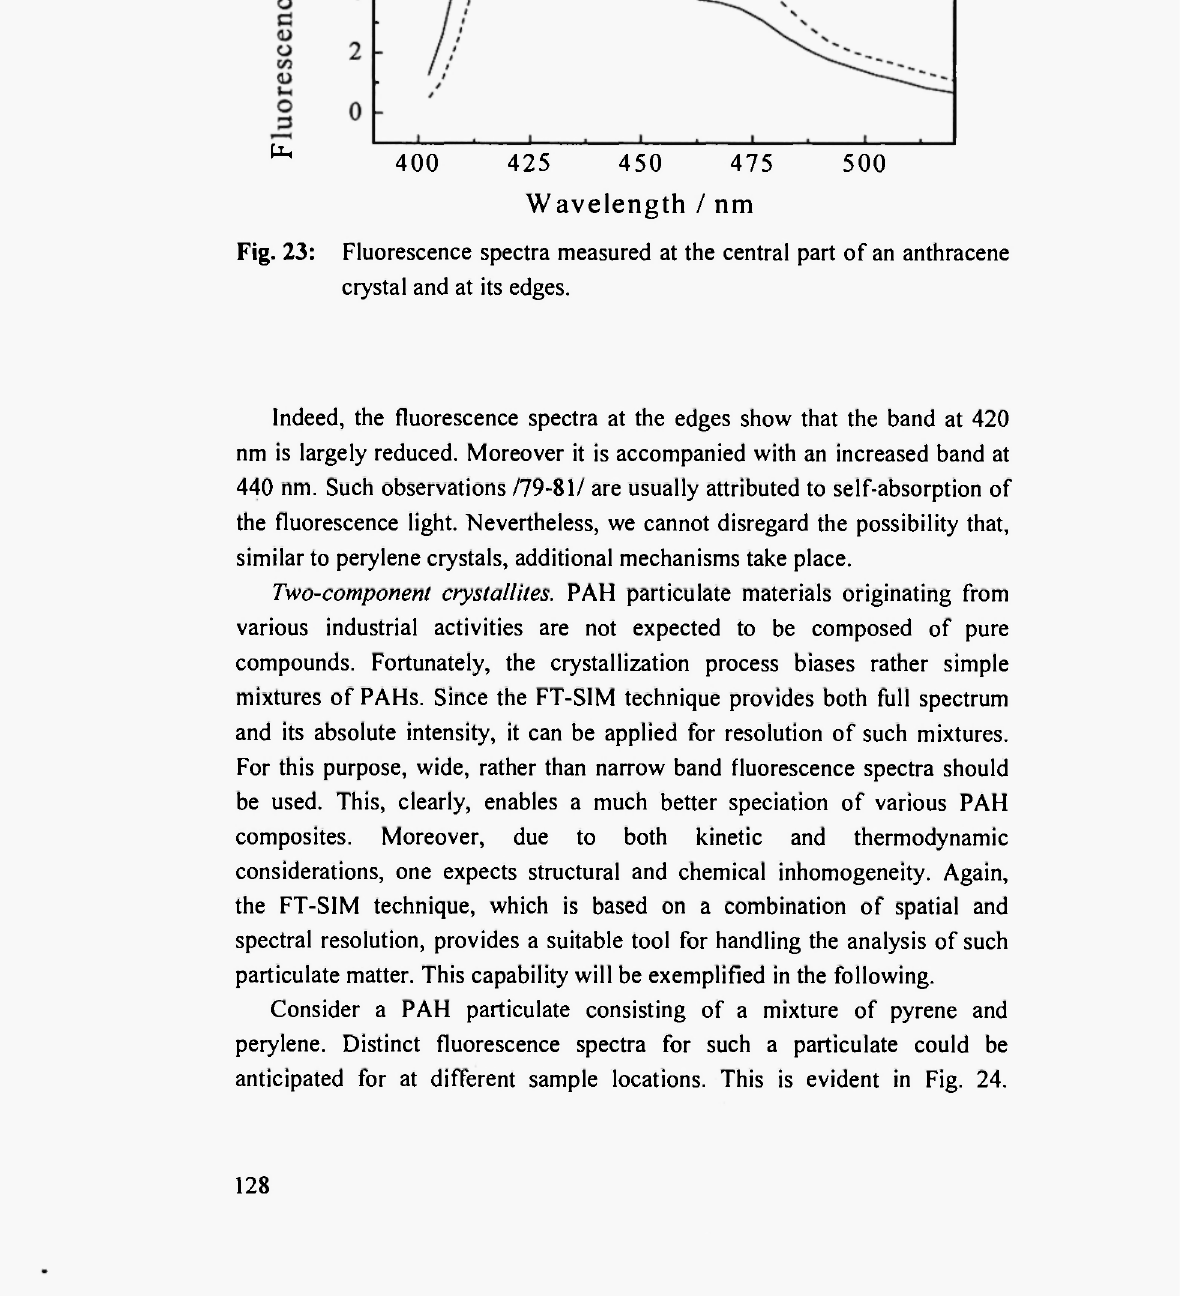
fa 4 00 5 00 4 25 4 50 4 75 Wavelength / nm Fig. 23: Fluorescence spectra measured at the central part of an anthracene crystal and at its